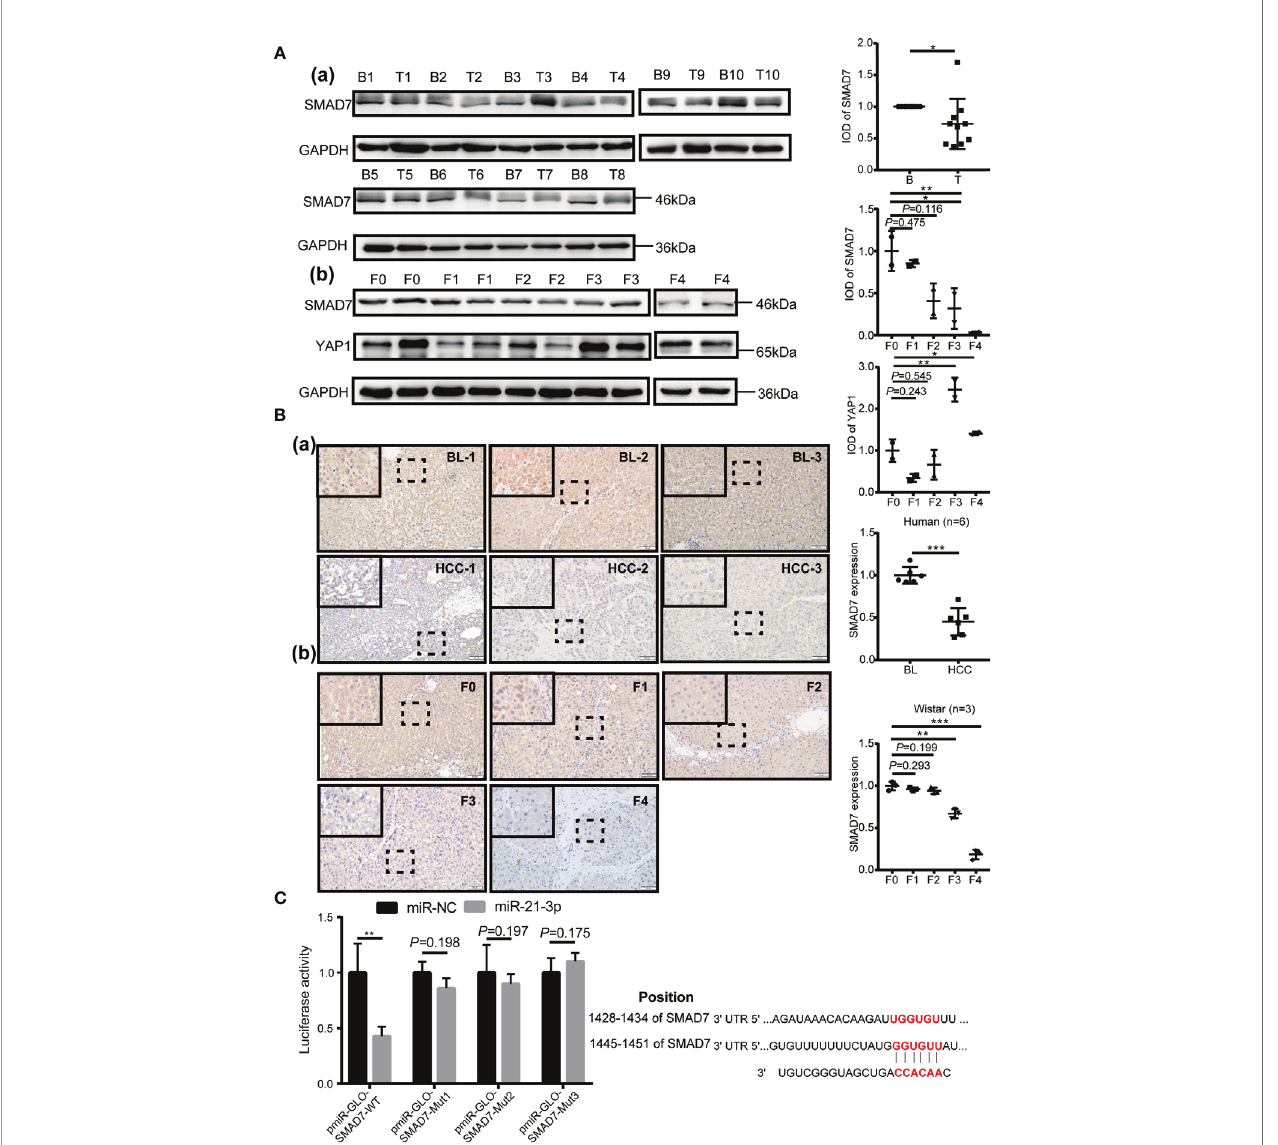
(F1 – F3) and cirrhotic (F4) tissue (b). (B) SMAD7 expression in HCC (a) and rat liver tissue in different stages of tumorigenesis (b) as illustrated by immunohistochemical methods (magni fi cation 400×). Six paired human and three rat samples from each group were statistically analyzed. (C) Base pairing complement detailed the two putative YAP1 miR-21-3p binding sites at 3 ’ -UTR predicted by TargetScan. PmiR-GLO-SMAD7 vector was co-transfected with mimic-21 or mimic-NC; wild-type (WT); or mutant (Mut). Mut-1-2 represents the two predicted binding sites. Mut-3 represents two mutant binding sites. Luciferase activity assay of pmiR-GLO-SMAD7-3 ’ -UTR co-transfection with miR-21-3p or NC mimics. Fire fl y luciferase activity was measured 24 h after transfection and normalized to Renilla luciferase activity. All data for miR-NC groups were set as 1. All experiments were performed in triplicate. Data are presented as mean ± SEM. *P < 0.05,**P < 0.01, ***P <